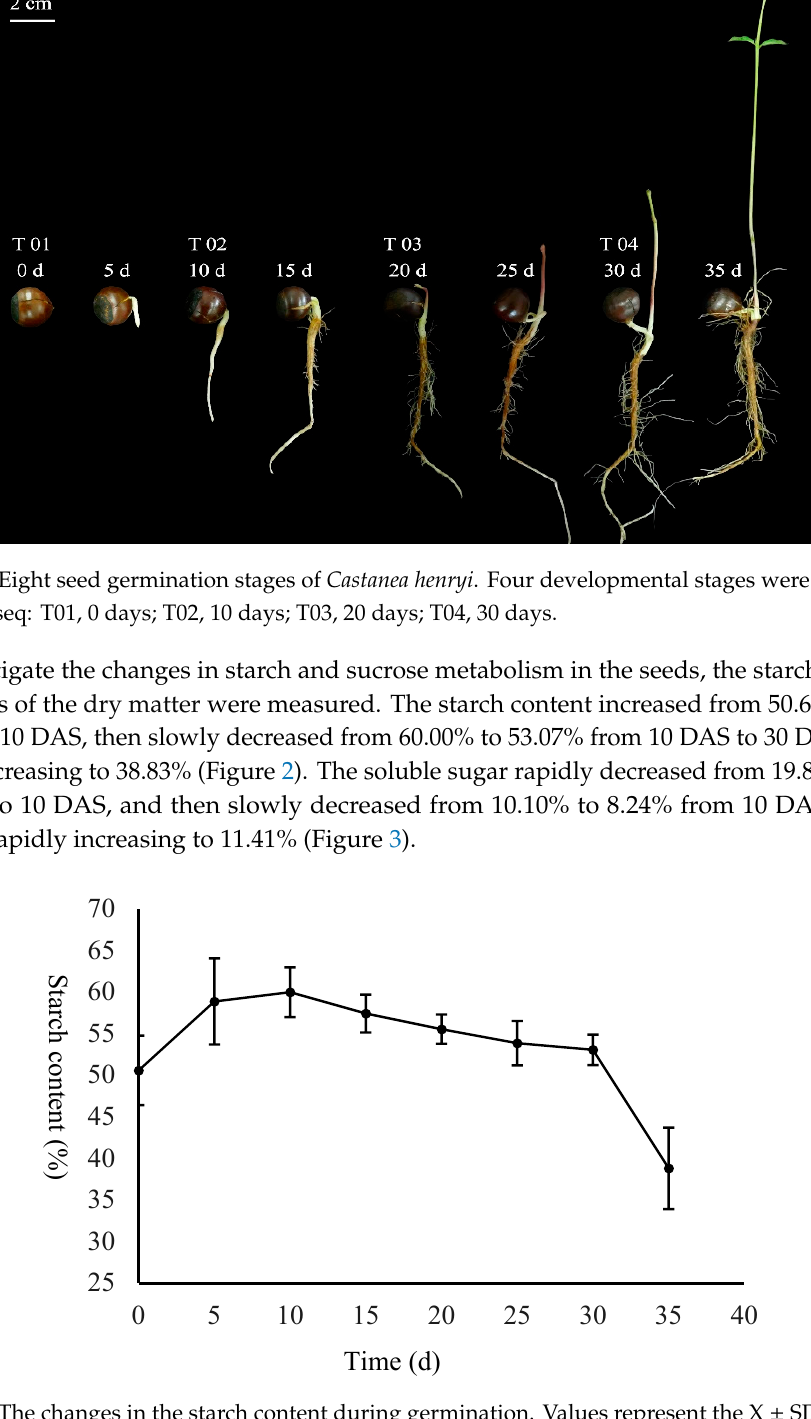
Figure 2. The changes in the starch content during germination. Values represent the ⎯ X ± SD of three biological replicates.